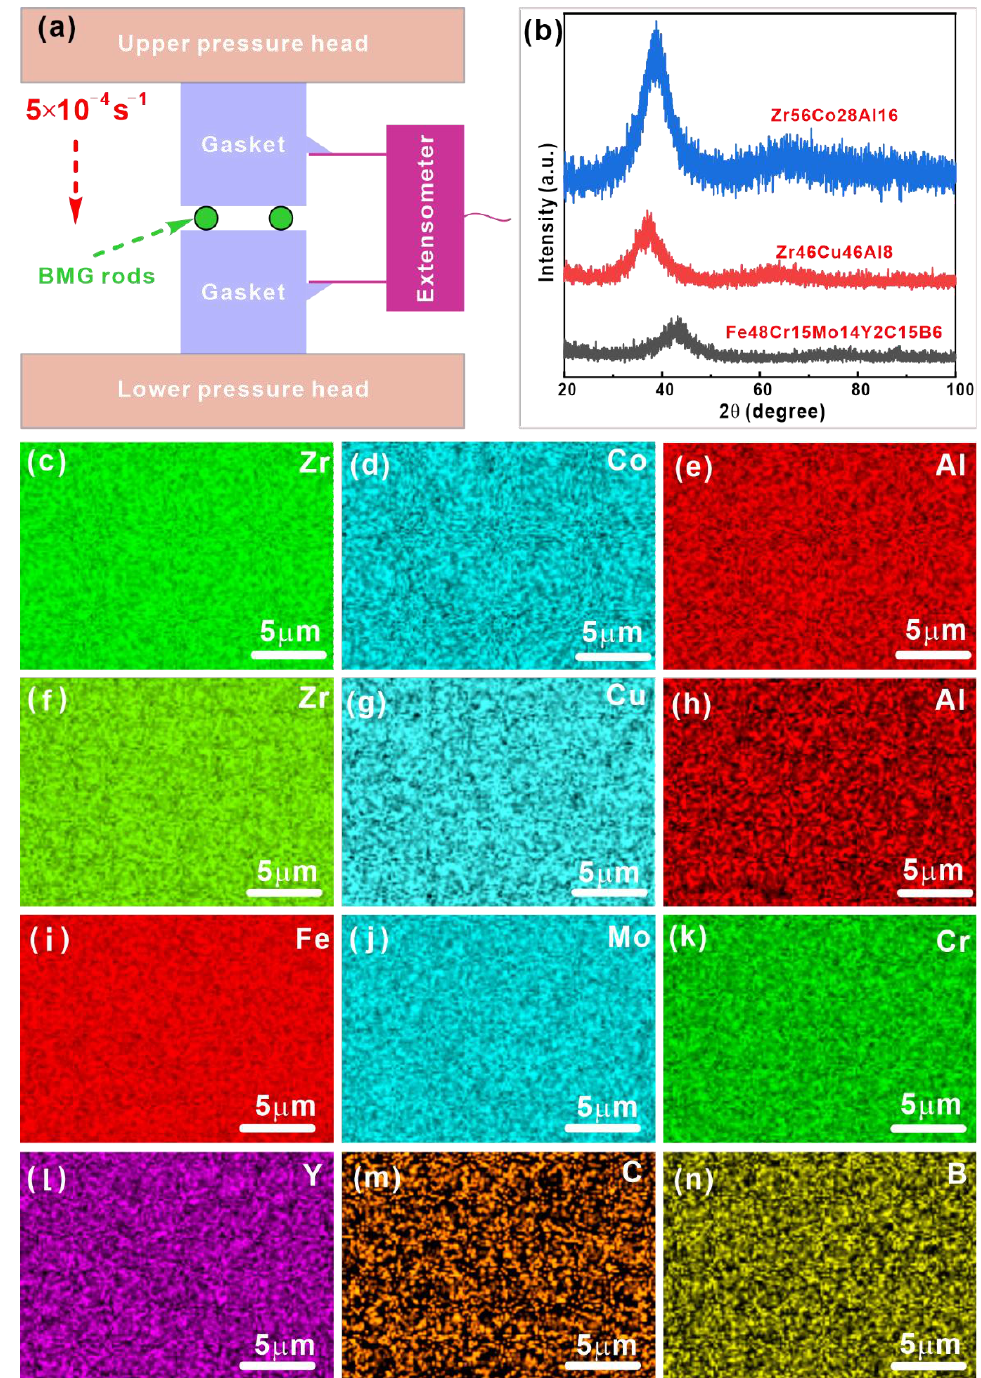
Figure 1. ( a ) Schematic diagram of the PPD processing on BMG rods, ( b ) XRD patterns of BMGs after plastic deformation, EDS mapping results of ( c – e ) Zr 56 Co 28 Al 16 , ( f – h ) Zr 46 Cu 46 Al 8 , and ( i – n ) Fe 48 Cr 15 Mo 14 Y 2 C 15 B 6 BMGs. Uniaxial compression tests were conducted using an electronic tensile testing machine under a strain rate of 2.5 × 10 −4 s −1 . The dimension of the specimens for compression was Φ 2 mm × 4 mm. The shear bands induced by PPD treatments were observed, and the surface morphologies after fracture were also investigated using SEM. Furthermore, Young’s modulus was measured using a nanoindentation device (Anton Paar CSM-NHT 2 , Ashland, VA, USA). During nanoindentation, a maximum force of 50 mN was